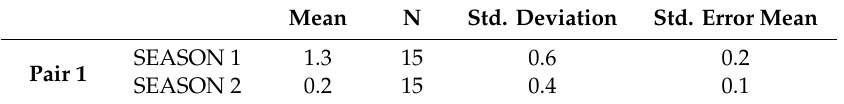
Table A11. Paired Samples Statistics.